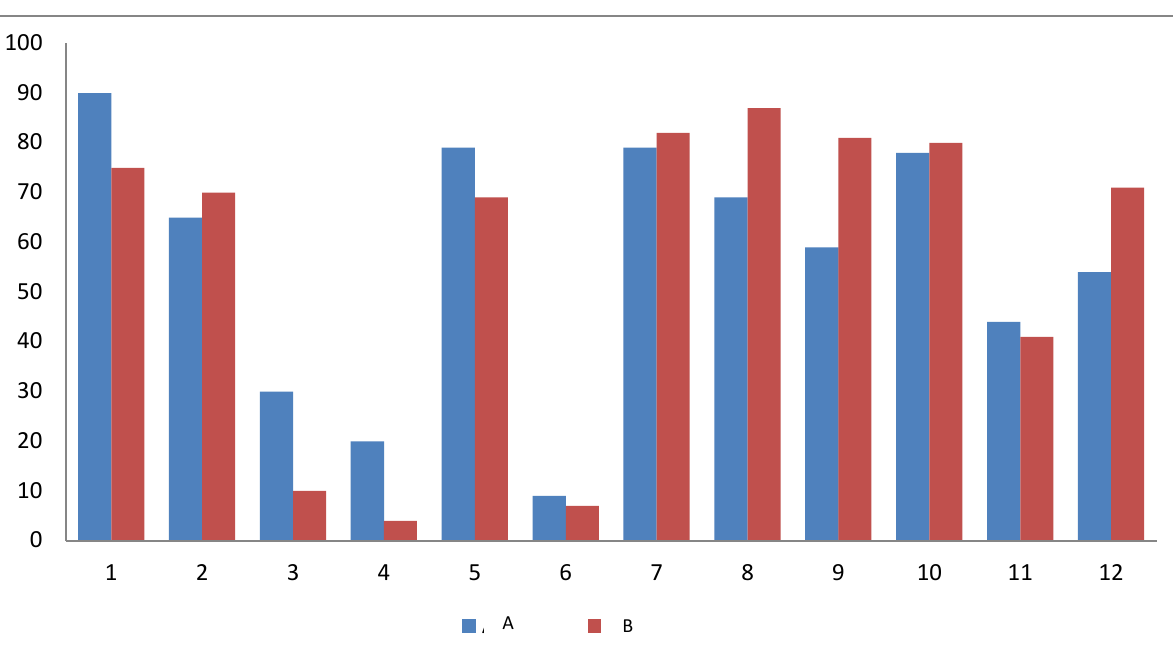
Fig.1. Aims, which respondents of 50-65 years old want to achieve in free time: 1 – rest to forgive about